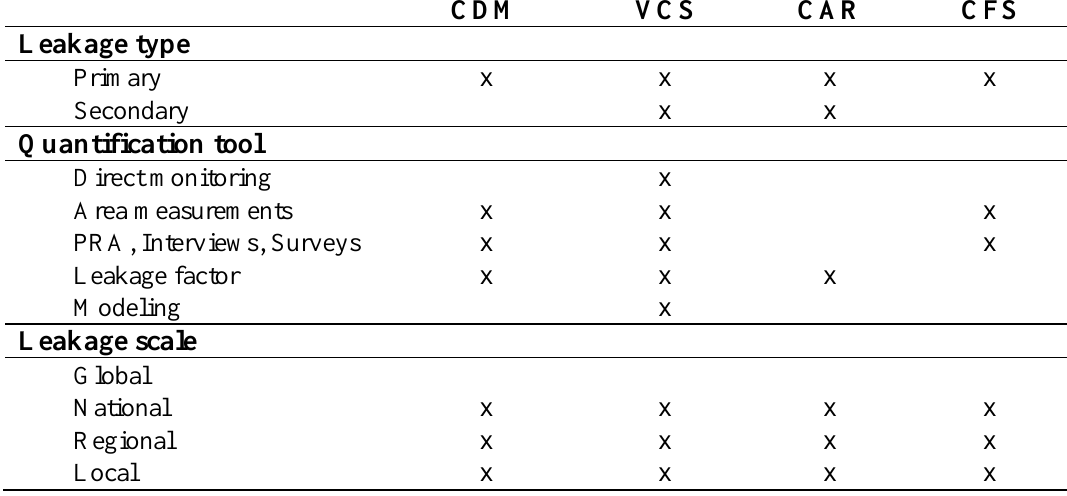
Table 4. Carbon standards addressing basic leakage characteristics: Leakage type, Quantification tool, Geographical scale. CDM—Clean Development Mechanism, VCS— Verified Carbon Standard, CAR—Climate Action Reserve, CFS—Carbon Fix